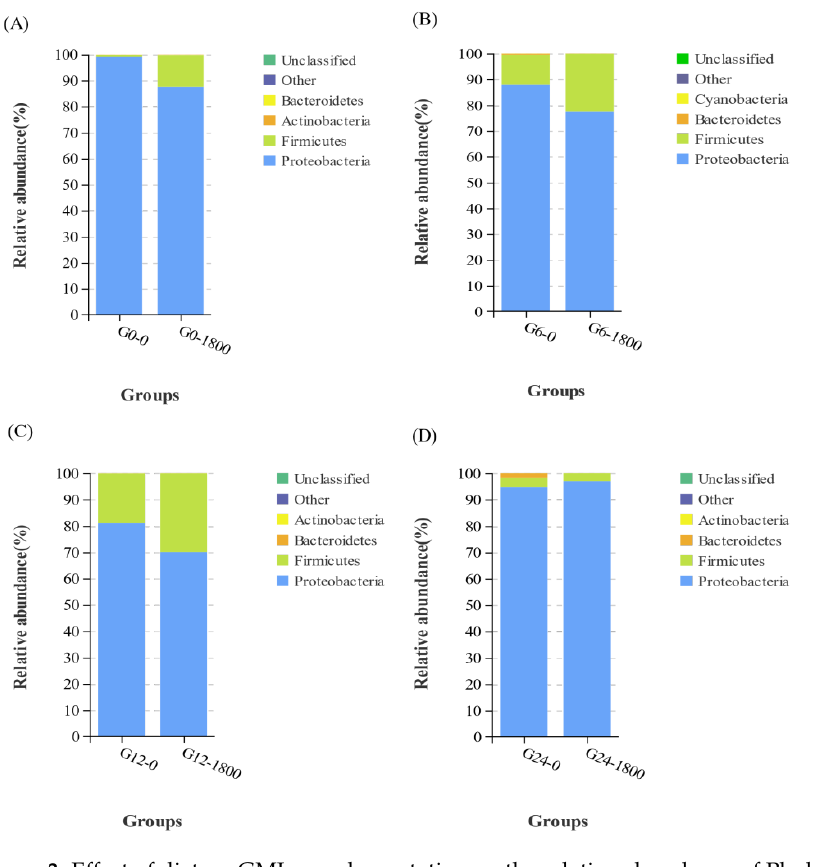
Figure 3. Effect of dietary GML supplementation on the relative abundance of Phylum in grouper intestinal flora under salinity stress. ( A ), ( B ), ( C ), and ( D ) represent the relative abundance of Phylum level of G0 group and G1800 group at 0 h, 6 h, 12 h, and 24 h, respectively.